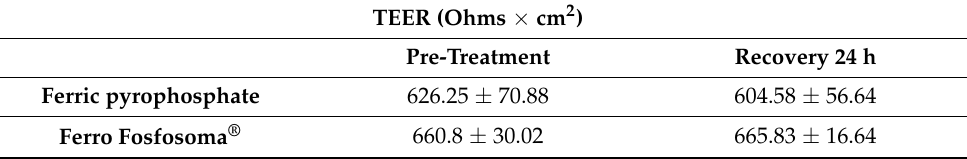
Table 8. TEER values in Caco-2 monolayer at the end of the 3 h incubation with bioaccessible fractions of ferric pyrophosphate salt and granular forms of ferric pyrophosphate. Results are expressed as mean ± standard